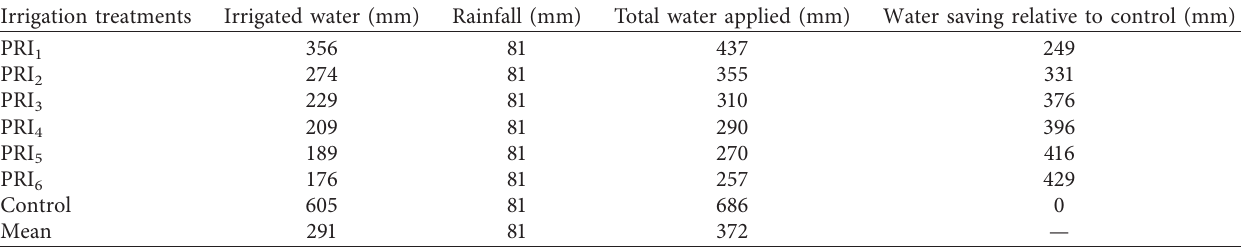
Table 1: Rainfall and total water supply (irrigation plus rainfall) of PMK ( R ) 3 rice by split root experiment.